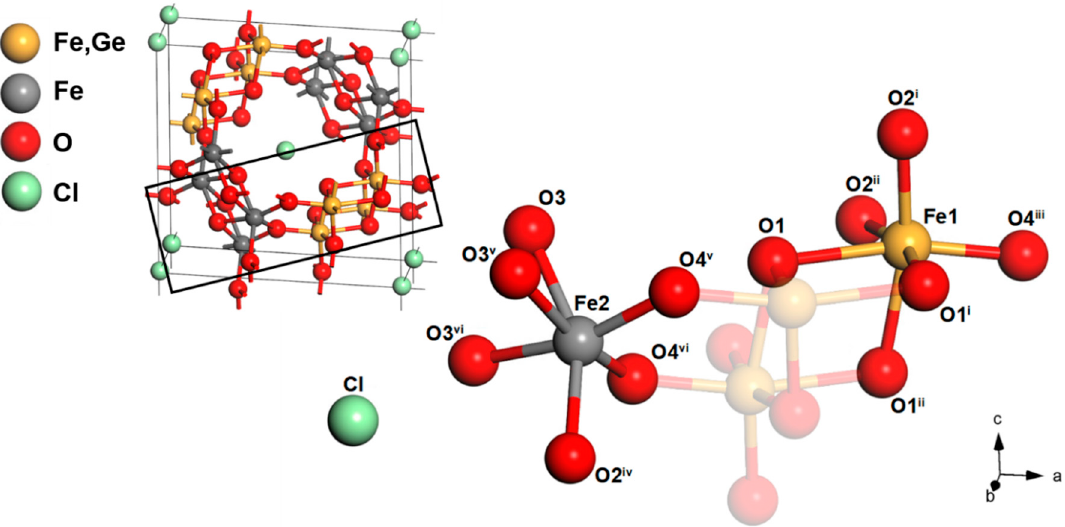
Figure 2. The refined octahedron units of Fe sites and Cl position in the newly proposed Ge ‐ akaganéite after the Rietveld refinement. The selected bond lengths are presented in Table 2. [Symmetry code(s): (i) – x + 3/2, y − 1/2, − z + 1/2; (ii) – x + 3/2, y + 1/2, − z + 1/2; (iii) x + 1, y , z ; (iv) – x + 1, y , − z ; (v) – x + 1/2, y − 1/2, − z + 1/2; (vi) – x + 1/2, y + 1/2, − z + 1/2].